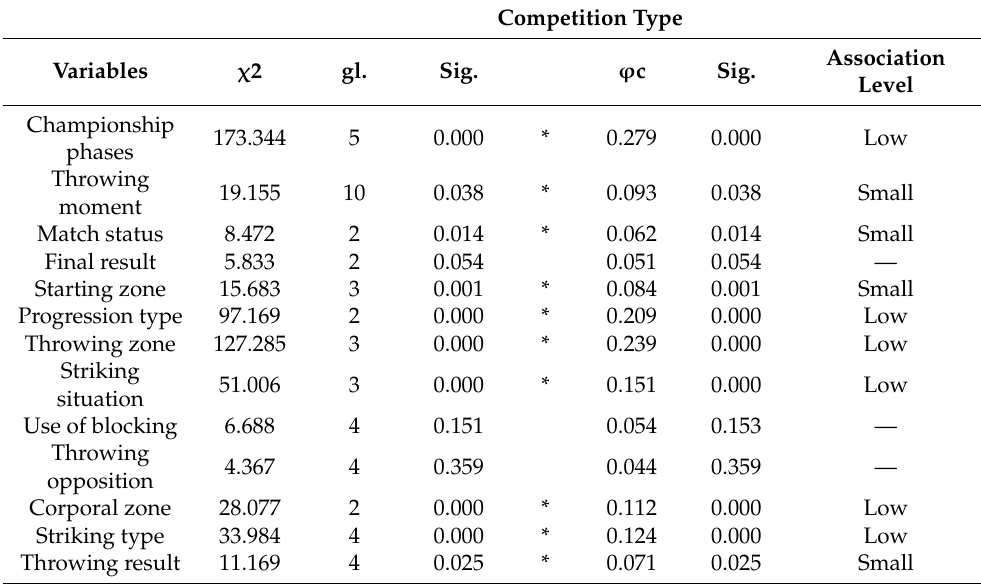
Table 2. Relationship between the “ Competition type ” variable and the dependent